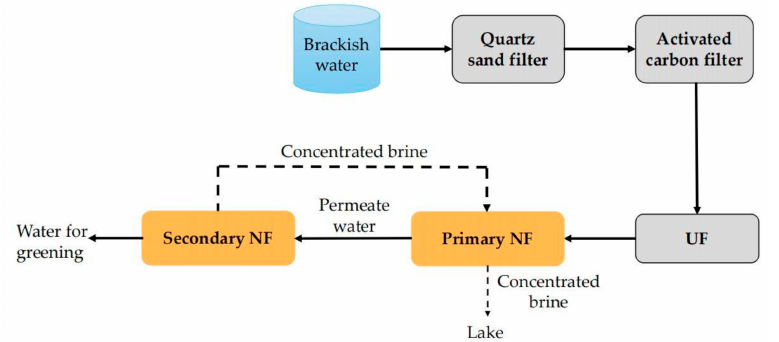
Figure 8. Flow chart of two-stage NF process.